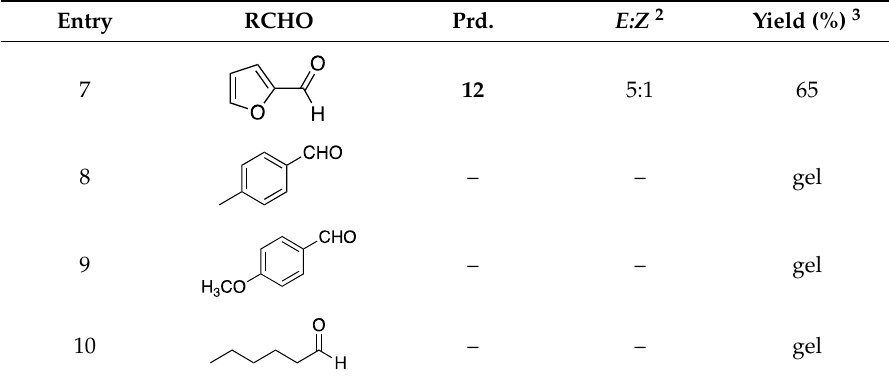
4 of 8 Figure 1. Photographs of crude, partial 1 H NMR spectra of 5 (top) and 6 (bottom) showing the chemical shifts of the indicated protons for 6 . We next set out to determine the aldehyde scope of this reaction. As can be seen in Table 1, aldehydes containing various electron withdrawing groups were well tolerated, providing cinnamate products in moderate to good yields with good E/Z ratios (Table 1, entries 1–6). Heterocyclic aromatic aldehydes (e.g., furfural) could also be utilized (Table 1, entry 7). Unfortunately, this system is not without limitations; it was discovered that aliphatic aldehydes and aromatic aldehydes containing electron donating groups resulted in substantial cross-linking, as indicated by the complete gelation of the reaction mixture (Table 1, entries 8–10). This is probably caused by the lower electrophilicity of carbonyls containing electron donating groups. Table 1. Aldehyde scope for Wittig reactions. 1 Entry